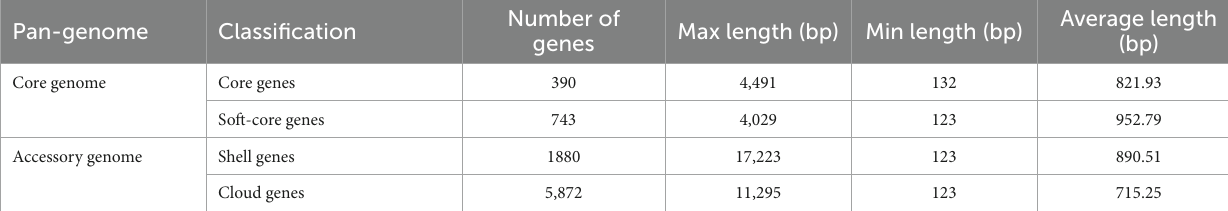
TABLE 3 Characteristics of the core genome and the accessory genome. Pan-genome